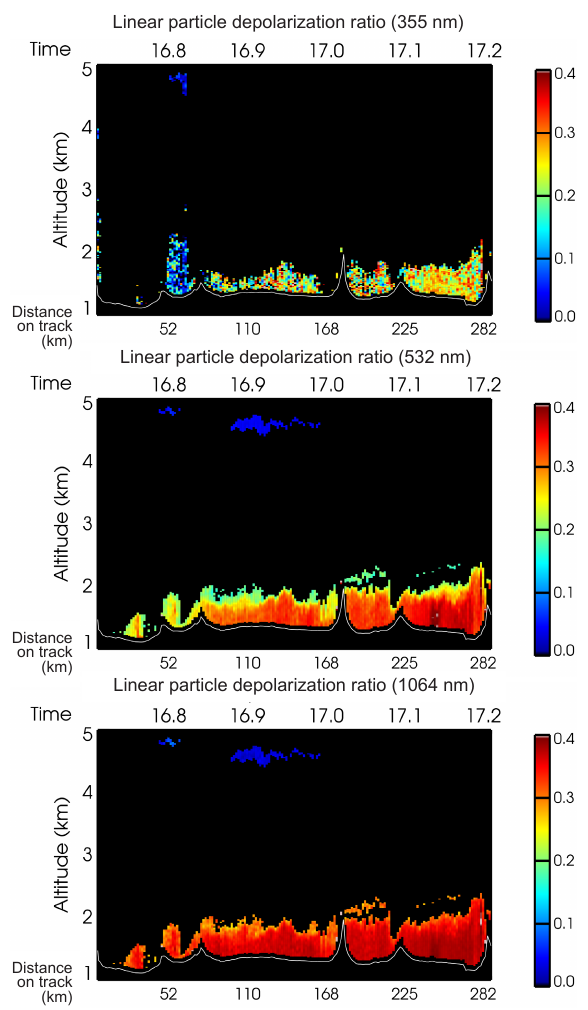
Figure 7. The linear particle depolarization ratio at three wave- lengths observed by HSRL-2 on 8 February 2013 in the southwest- ern US for the flight segment shown in Fig.